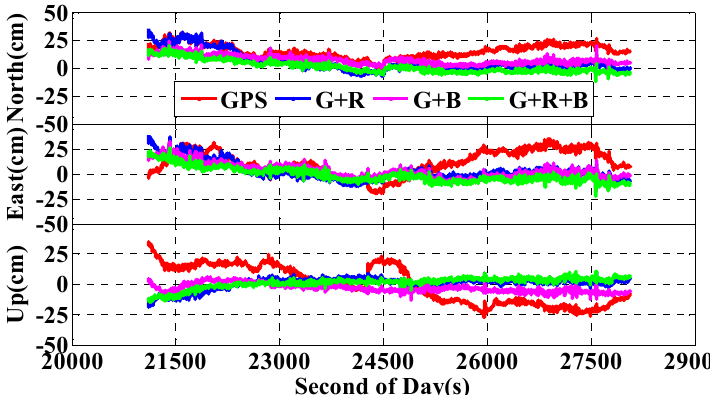
Figure 9. Position offsets time series in navigation frame (North-East-Up) calculated by making differences between the references and the solutions of the Helmert variance component based adaptive Kalman filter based PPP/INS tightly coupled integration using the single- (GPS) and the multi-GNSS (G + R, G + B, and G + R + B) data. Table 4. Improvements of the GNSS PPP/INS tightly coupled integration with the aids of the Helmert variance component estimation based adaptive Kalman filter by using GPS, G + R, G + B, and G + R + B data.